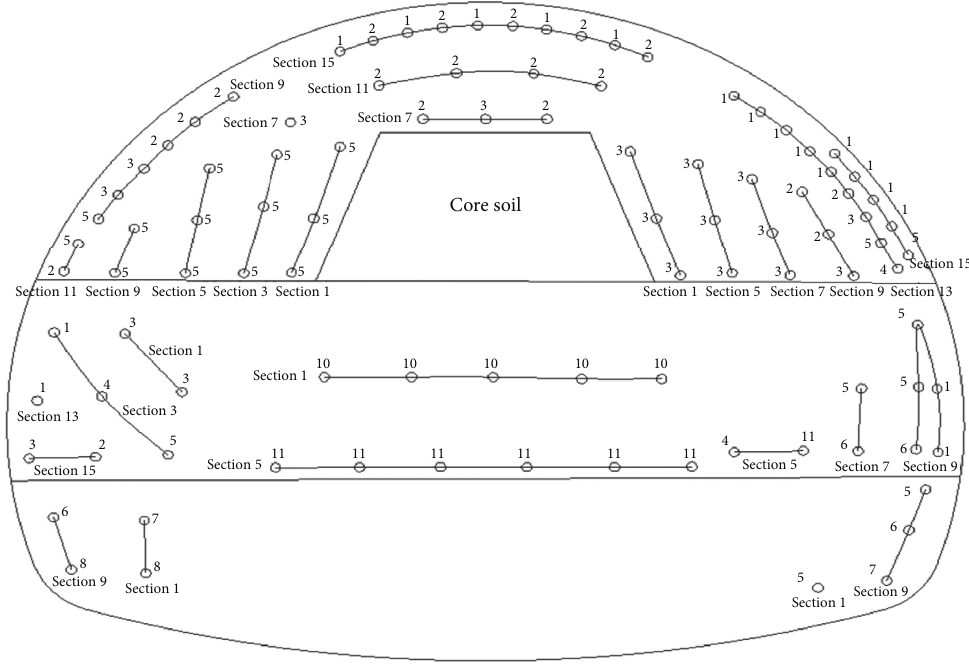
Figure 3: Arrangement diagram of blast